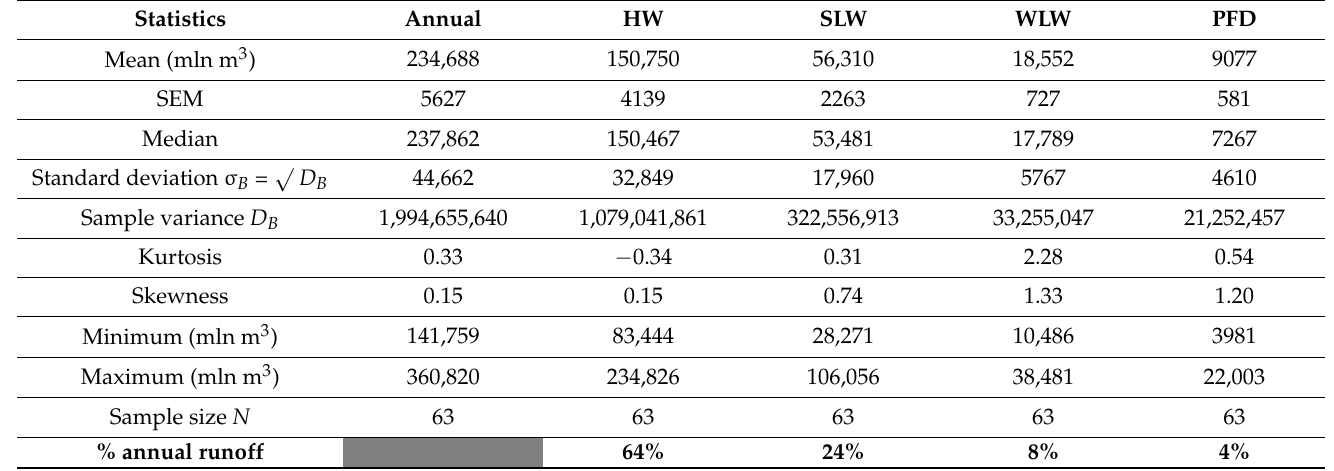
Table 7. The distributions’ numerical characteristics for the 1916–1978 series.